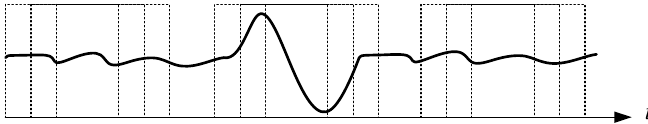
Figure 13. An illustration of pattern sampling and collection via the mobile app module.